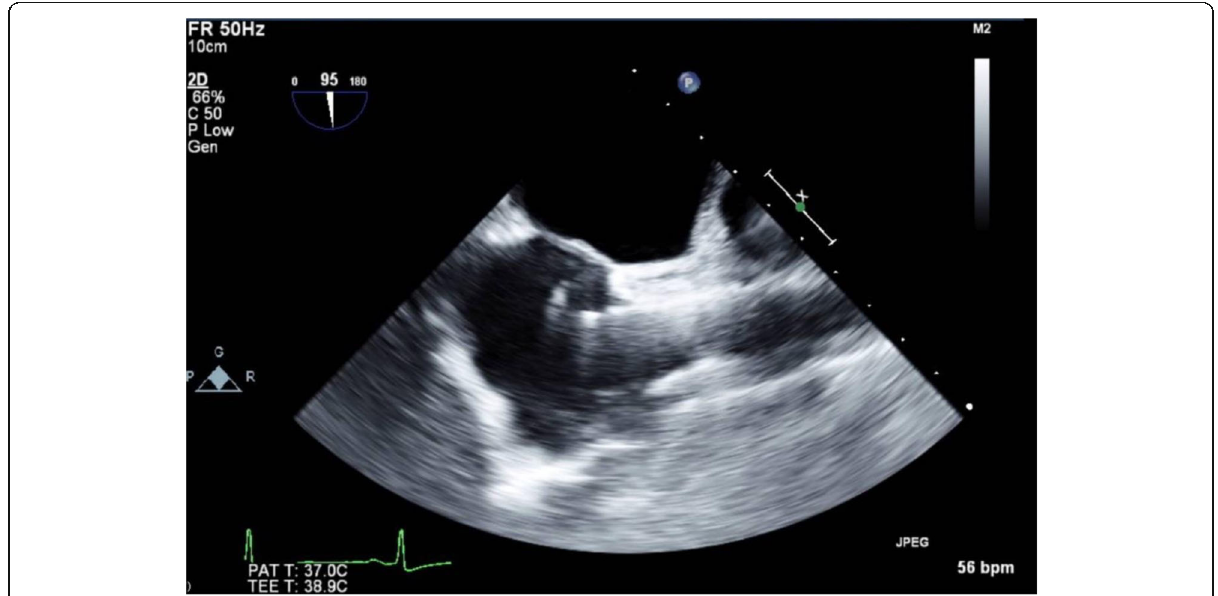
Fig. 5 The bicaval view was obtained at